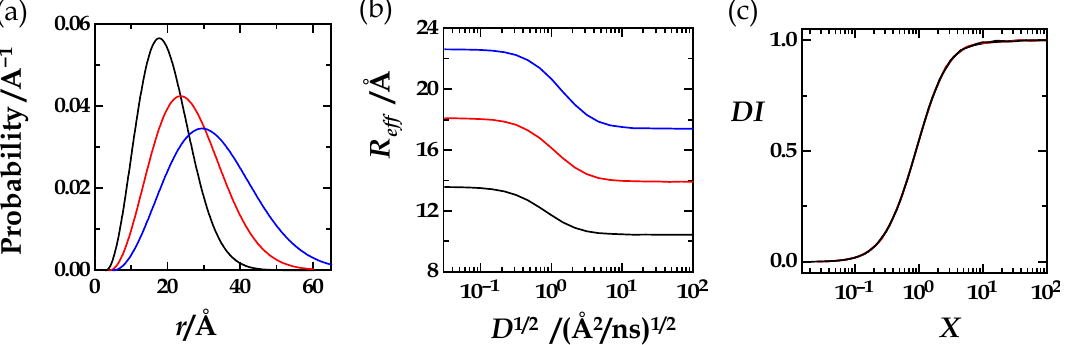
Figure 5. ( a ) Three ideal-chain distance distributions (Equation (18)) with b =18Å, r L =3Å (black curve); b = 24Å, r L = 4Å (red curve); and b = 30Å, r L = 5Å (blue curve). ( b ) The corresponding diffusion profiles obtained with b = 18Å, r L = 3Å, R 0 = 9Å (black curve); with b = 24Å, r L = 4Å, R 0 = 12Å (red curve); and with b = 30Å, r L = 5Å, R 0 = 15Å (blue curve). Thus, for all three evaluated distributions (black, red, blue), the ratio R 0 / r L equaled 3. ( c ) The corresponding diffusion-influence profiles with DI plotted against X ( X = J 1/2 ) . The three profiles merge into one.